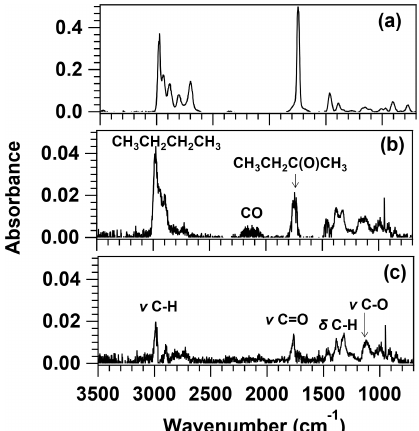
Figure 4. FTIR spectra of a 2-methylbutanal and air mixture (a) be- fore irradiation and (b) after 150min of photolysis with the features of 2MB subtracted (major products are labelled in the spectrum, exact positions of the bands are given in the main text), as well as (c) residual spectrum after the subtraction of the reference spectra of the identified products shown in Fig.